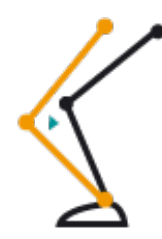
14 of 25 Figure 12. Gesture recognition: from left to right, the circle represents the tracking of the hand from one side to the other. The gray circle indicates that the final pose has been identified. 2.6. Real-Time Assessment of the Level of Achievement based on Loose Tolerance Margins The system includes several mechanisms to evaluate the real-time execution of exer- cises and the achievement of objectives. In addition to algorithms such as the one de- scribed in Section 2.4, to control the performance of scapular retraction, the validity of many exercises is assessed through tolerance margins, as reported in [25]. In that work, a tolerance margin was defined as a customized 3D region outside of which any activity was deemed invalid. These tolerance margins are usually considered together with pos- tural margins, which are intended to avoid compensatory postural changes. To adapt the system to the reduced body competence of the elderly, all the margins involved in the evaluation of the implemented exercises have been relaxed. For example, in older users, an abduction or flexion of the arm usually involves a compensatory torso tilt that affects the posture of the body. In this case, the torso tilt tolerance has been ex- tended from 5 to 20 degrees tilt, which is about 15 degrees above the margin established for young adults without injury. In this way, older people can perform shoulder exercises